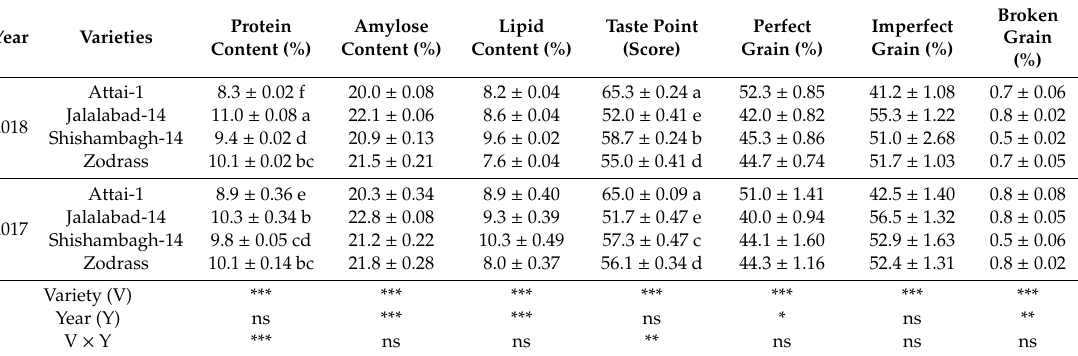
Table 5. Grain quality categories of selected rice varieties.